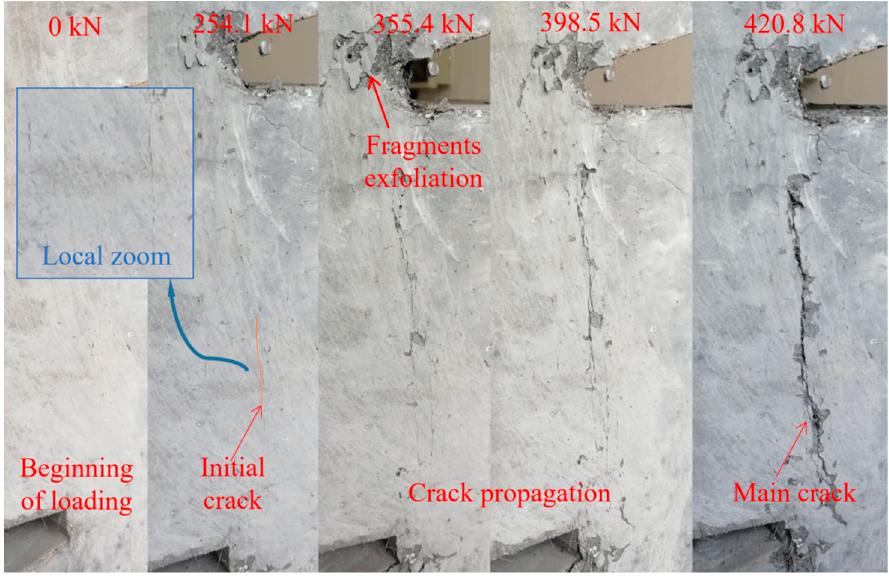
Figure 8. Failure modes and the crack propagation process.